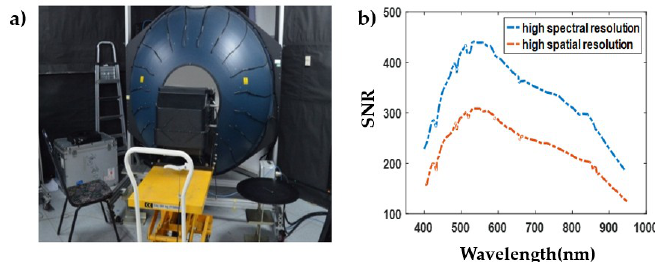
Figure 15. Scene of Signal-Noise Ratio (SNR) test ( a ) and the curve of SNR at central FOV ( b ).